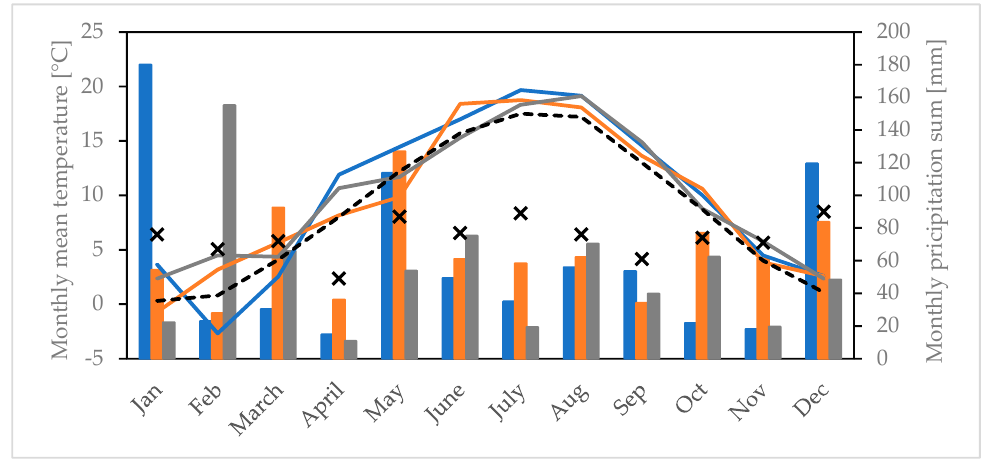
Figure 3. Monthly average temperature (lines) and monthly precipitation sum (bars) for the years 2018 (blue), 2019 (orange) and 2020 (grey) recorded at a nearby weather station (DWD station Neubulach-Oberhaugstett). x -axis: months, left y -axis: monthly mean temperature in °C, right y -axis: monthly precipitation sum in mm. Mean values (1991–2020) are displayed as black dashed lines (temperature) and crosses (precipitation).